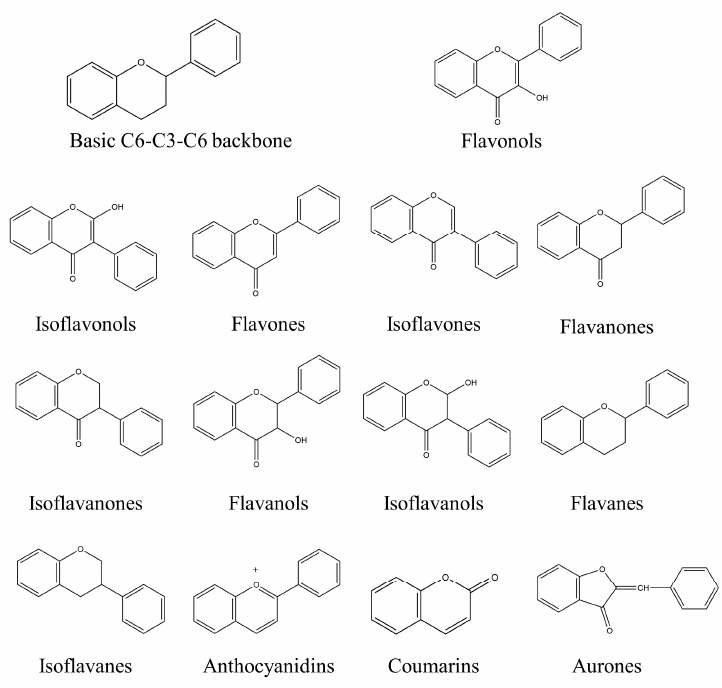
Figure 1. A basic structure of flavonoids.